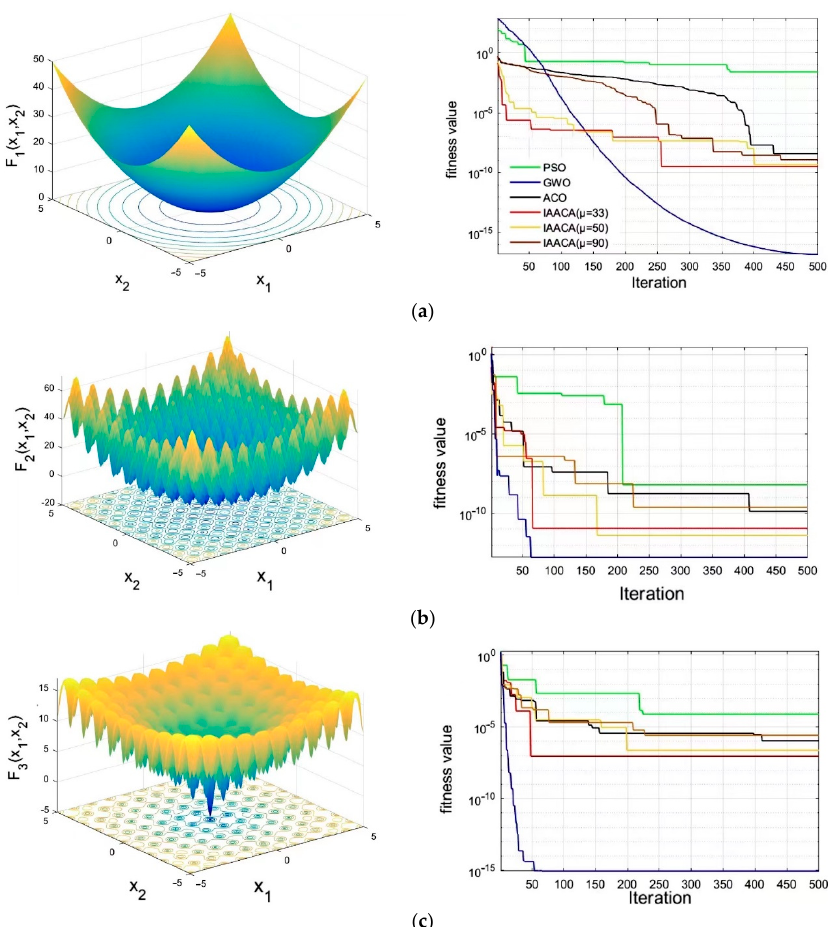
Figure 4. Convergence curves for PSO, GWO, ACO, and IAACA ( μ = 33, μ = 50, μ = 90) on differ- ent benchmark functions. ( a ) Convergence performance of swarm intelligence algorithms on the Sphere function. ( b ) Convergence performance of swarm intelligence algorithms on the Rastrigin function. ( c ) Convergence performance of swarm intelligence algorithms on the Ackley function.